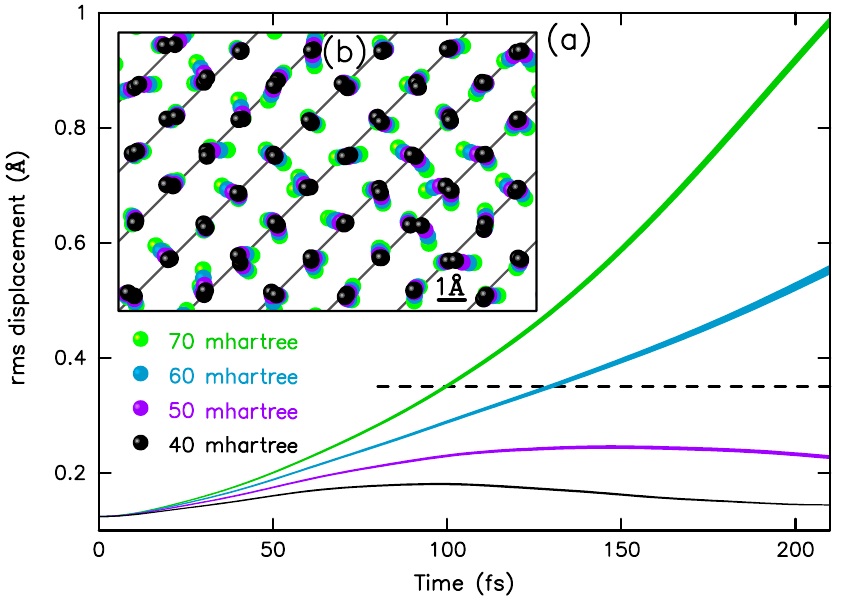
FIG. 1. Atomic pathways induced by a femtosecond-laser pulse for four different fluences. (a) Averaged root-mean-square displacements from equilibrium as a function of time. The vertical linewidths are twice the standard deviations of the averages shown. The dashed line indicates the Lindemann stability limit. (b) Snapshot after 146 fs of a particular run for each excitation strength. The atomic coordinates are projected in the z direction. The lines indicate ð 1 ; (cid:2) 1 ; 0 Þ lattice planes.